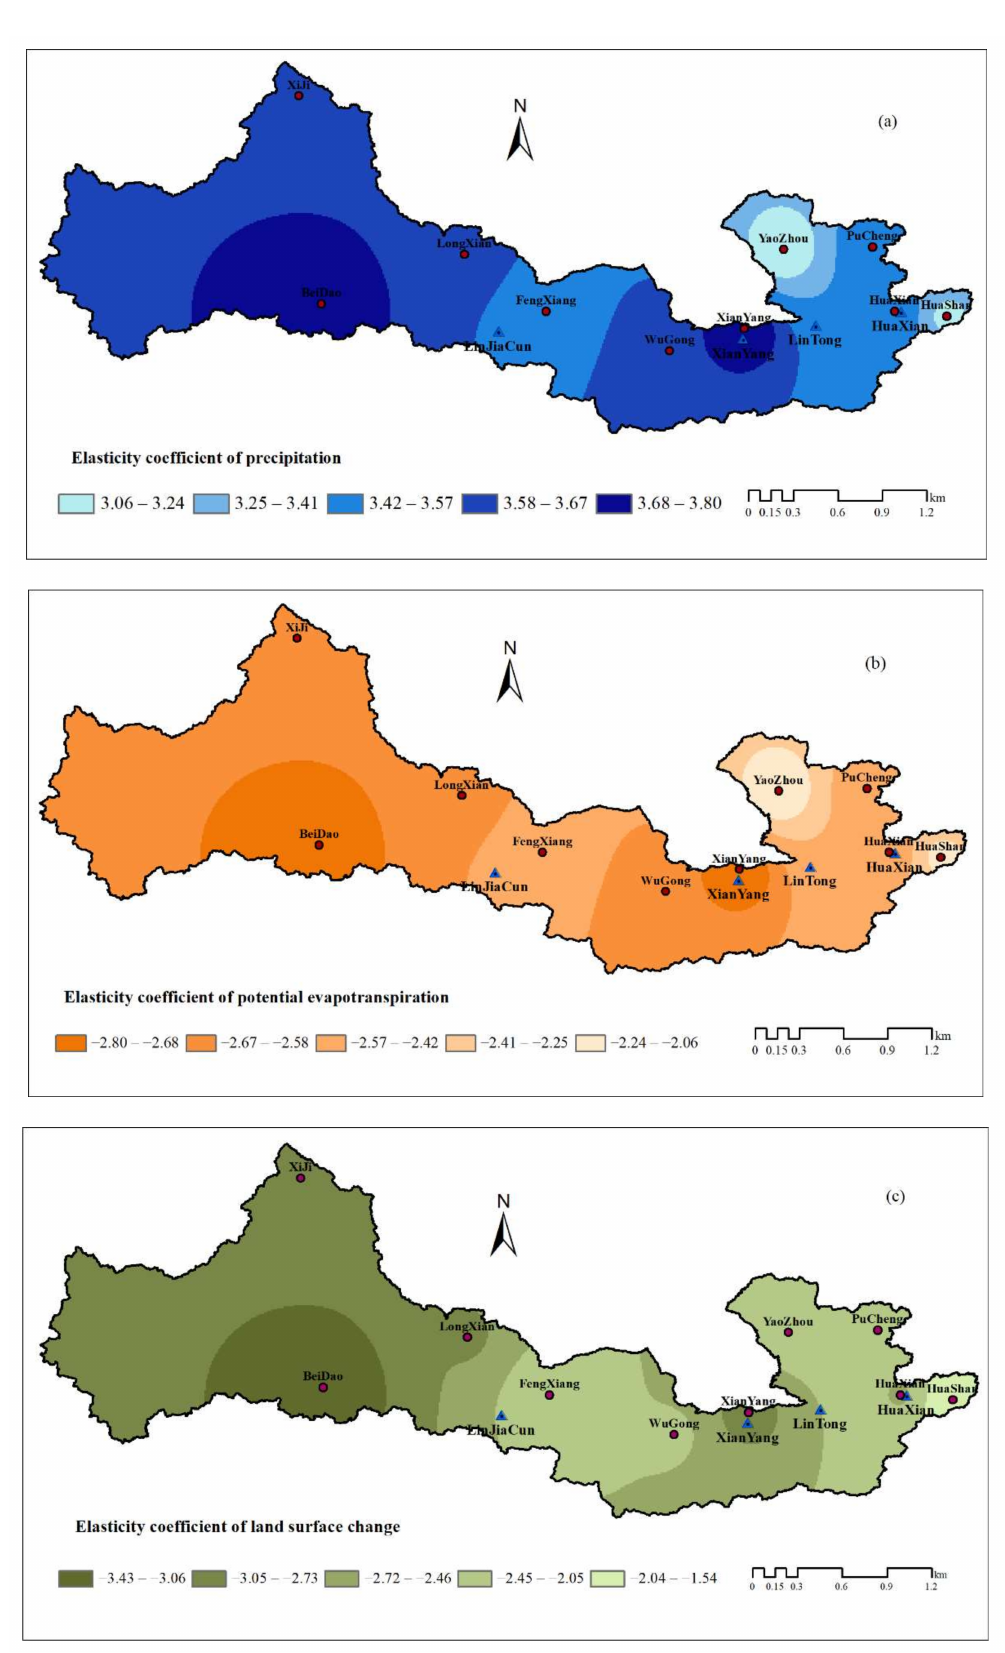
Figure 2. Spatial variation characteristics of the elasticity coefficient of runoff in the Weihe River Basin: elasticity coefficient of ( a ) precipitation; ( b ) potential evapotranspiration; ( c ) land surface